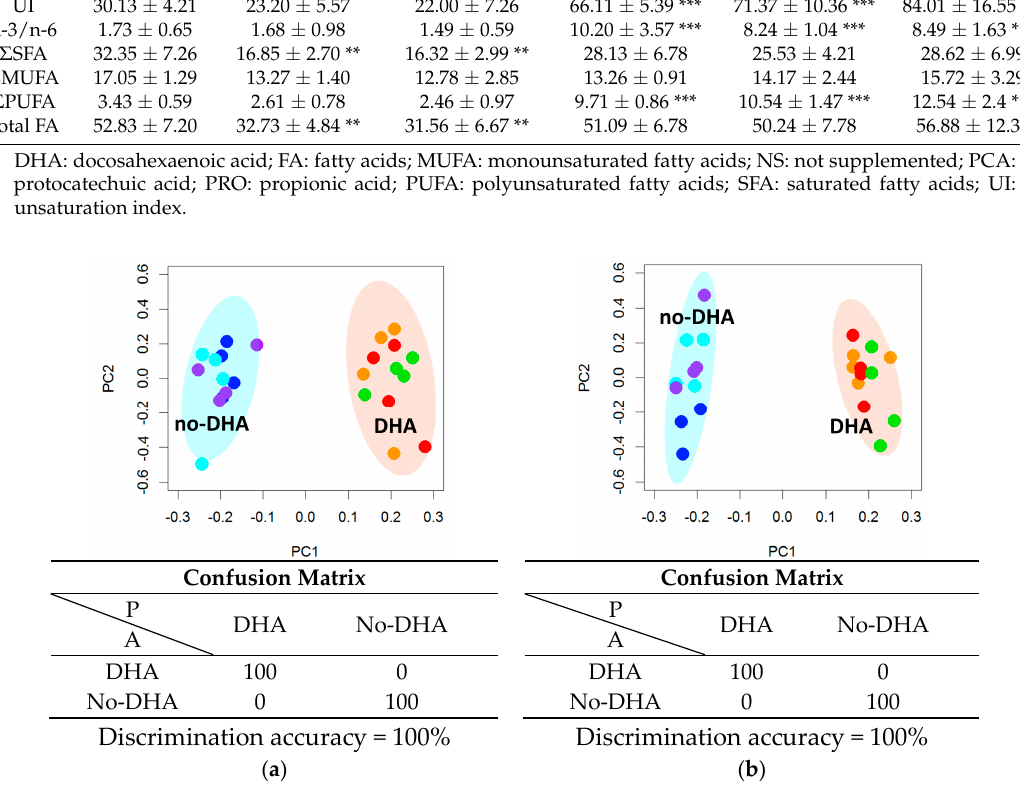
Figure 2. Fatty acid phenotyping by gas chromatography (GC) analysis of cells not supplemented (NS) and supplemented with docosahexaenoic acid (DHA), alone or in combination with protocatechuic acid (PCA) or propionic acid (PRO), after ( a ) 6 h and ( b ) 24 h supplementation. Principal component analysis and canonical analysis (PCA-CA) score plots: PC1 vs. PC2. In each group, four samples derived from three independent experiments were analyzed. Each symbol represents a different sample. Blue symbols = NS; purple symbols = PCA; cyan symbols = PRO; orange symbols = DHA; green symbols = DHA + PCA; red symbols = DHA + PRO. For each PCA-CA model, the confusion matrix and the discrimination accuracy are reported; A: actual classes; P: predicted classes.